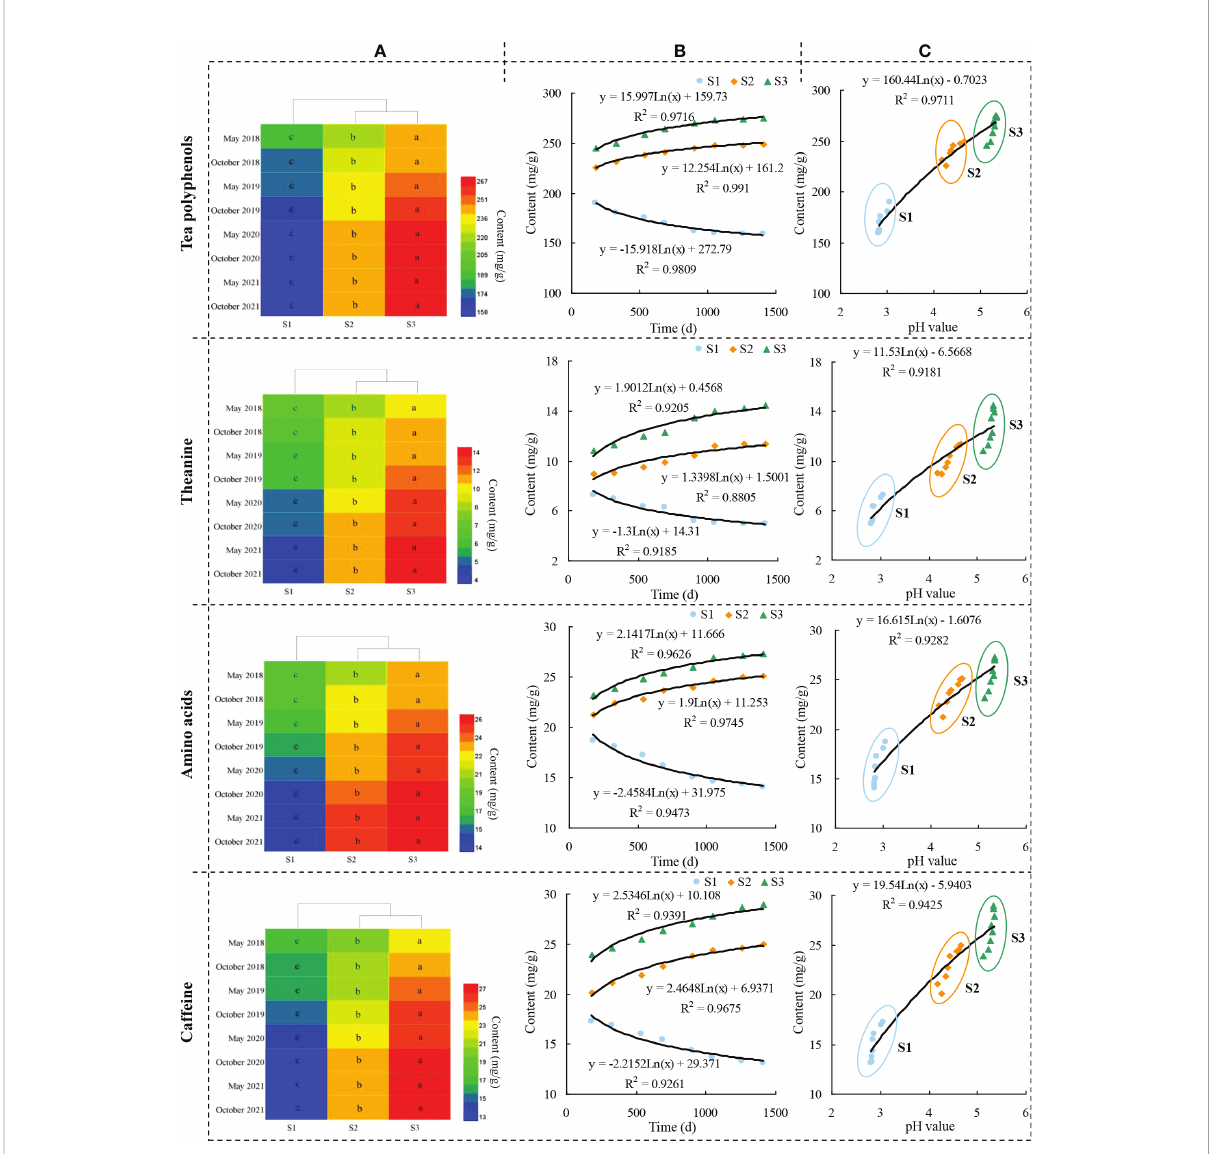
FIGURE 4 Effects of different fertilization treatments and soil pH on the content of tea leaf quality indexes. Note: S1: 100% Chemical fertilizer; S2: 50% Organic fertilizer +50% chemical fertilizer; S3: 100% Organic fertilizer; (A) : Effect of 4 consecutive years of fertilization treatment on the quality tea leaves; (B) Trend analysis of in fl uence of fertilization treatment on the quality tea leaves after 4 consecutive years; (C) Trend analysis of in fl uence of soil pH on the quality tea leaves. Different lowercase letters indicate the signi fi cant difference at P < 0.05 levels among different